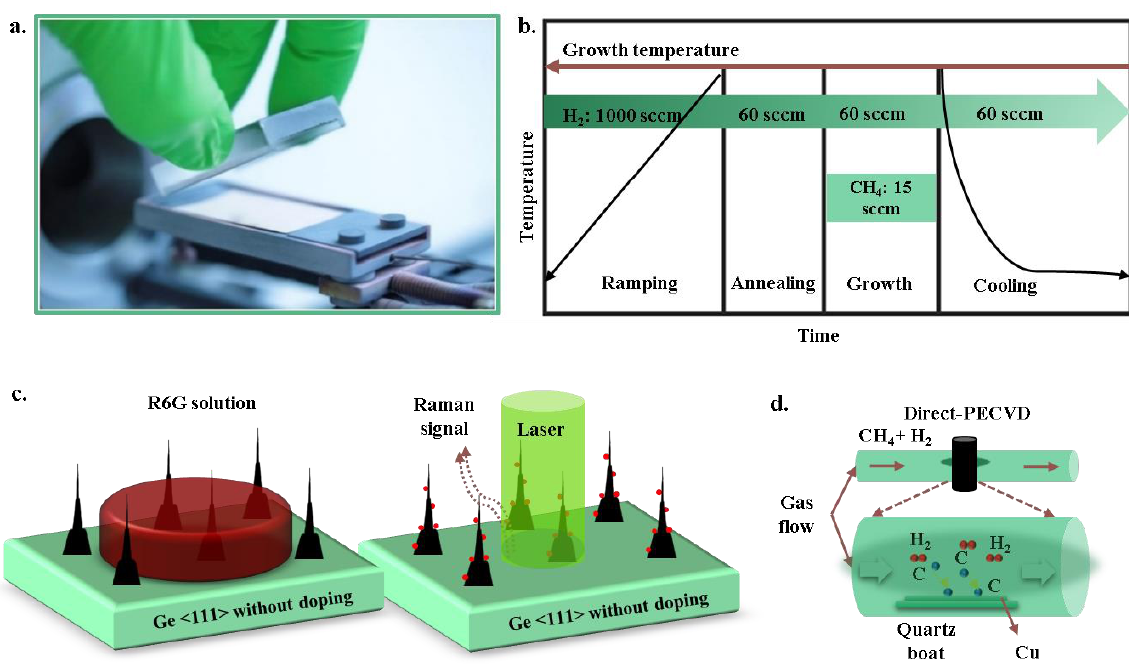
Figure 5. ( a ) Cold-wall chamber CVD growth of graphene. Reprinted with permission from Ref. [57]. Copyright © 2017, Elsevier. ( b ) The strategies that have been adopted during CVD-based graphene development. Adapted with permission from Ref. [58]. Copyright © 2017, RSC; ( c ) experimental process diagram, using VAGNAs as the SERS substrate. Adapted with permission from Ref. [59]. Copyright © 2022, Elsevier; and ( d ) production of twisted bilayer graphene with a controlled twist angle in sizes of mm and cm. Adapted with permission from Ref. [60]. Copyright © 2022, Elsevier.